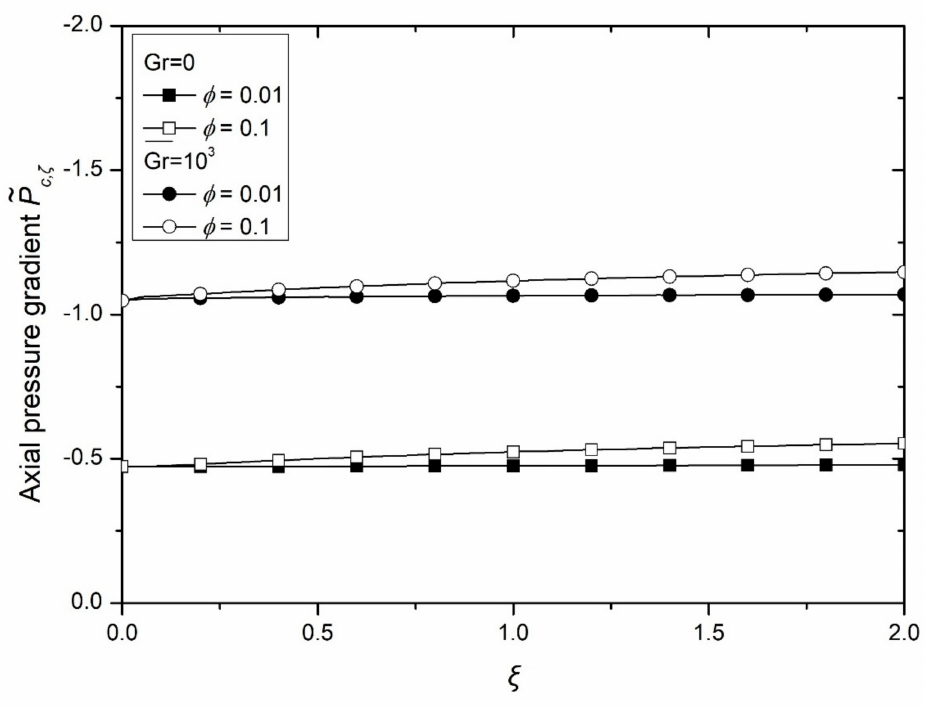
Figure 6. Effect of Gr, φ and ξ values on the axial pressure gradient (cid:101) P c , ζ